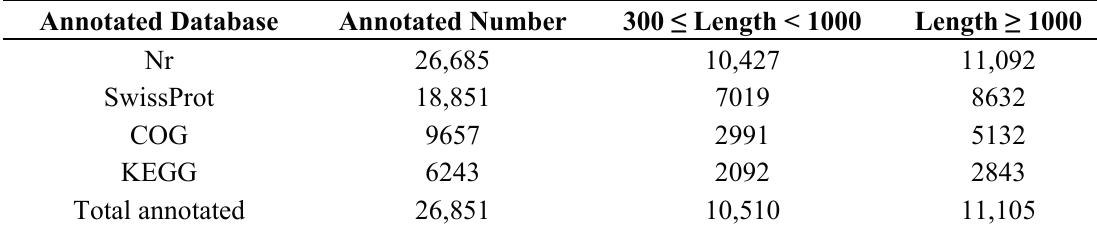
Table 2. Summary of unigene annotation using different